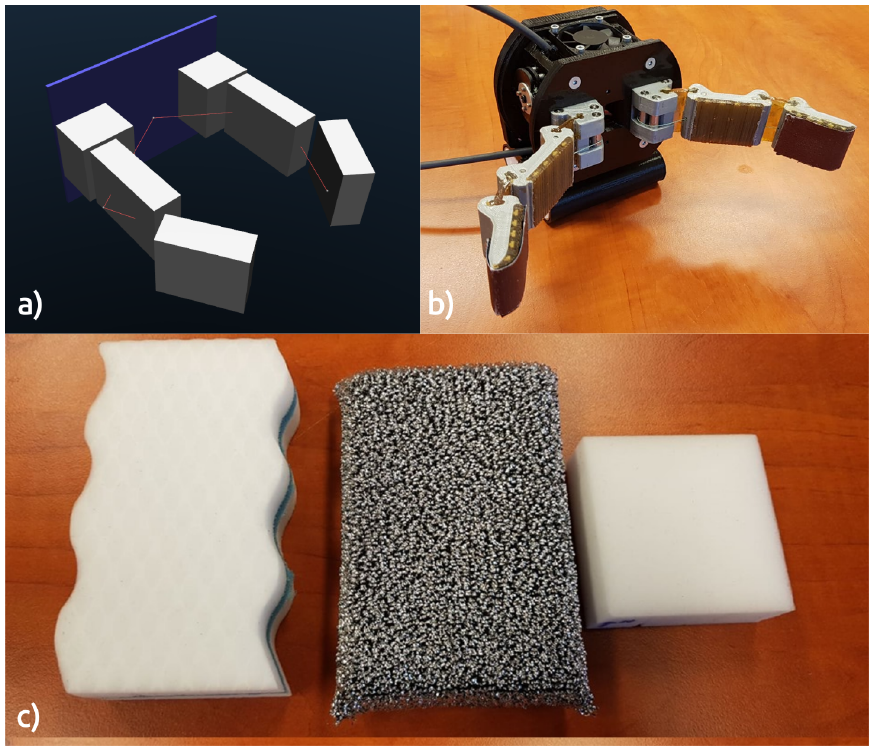
Figure 2. To test our system, we arranged a real-world scenario using a 2-finger Yale OpenHand gripper [2]. To provide a sufficient number of training samples for the learning process, we modelled the gripper in the MuJoCo simulator as it is depicted in ( a ). In ( b ), real fingers consist of three plastic blocks with flexible parts made of urethane. In ( c ), there are presented examples of sponges, exposing different stiffness, used in our real-world